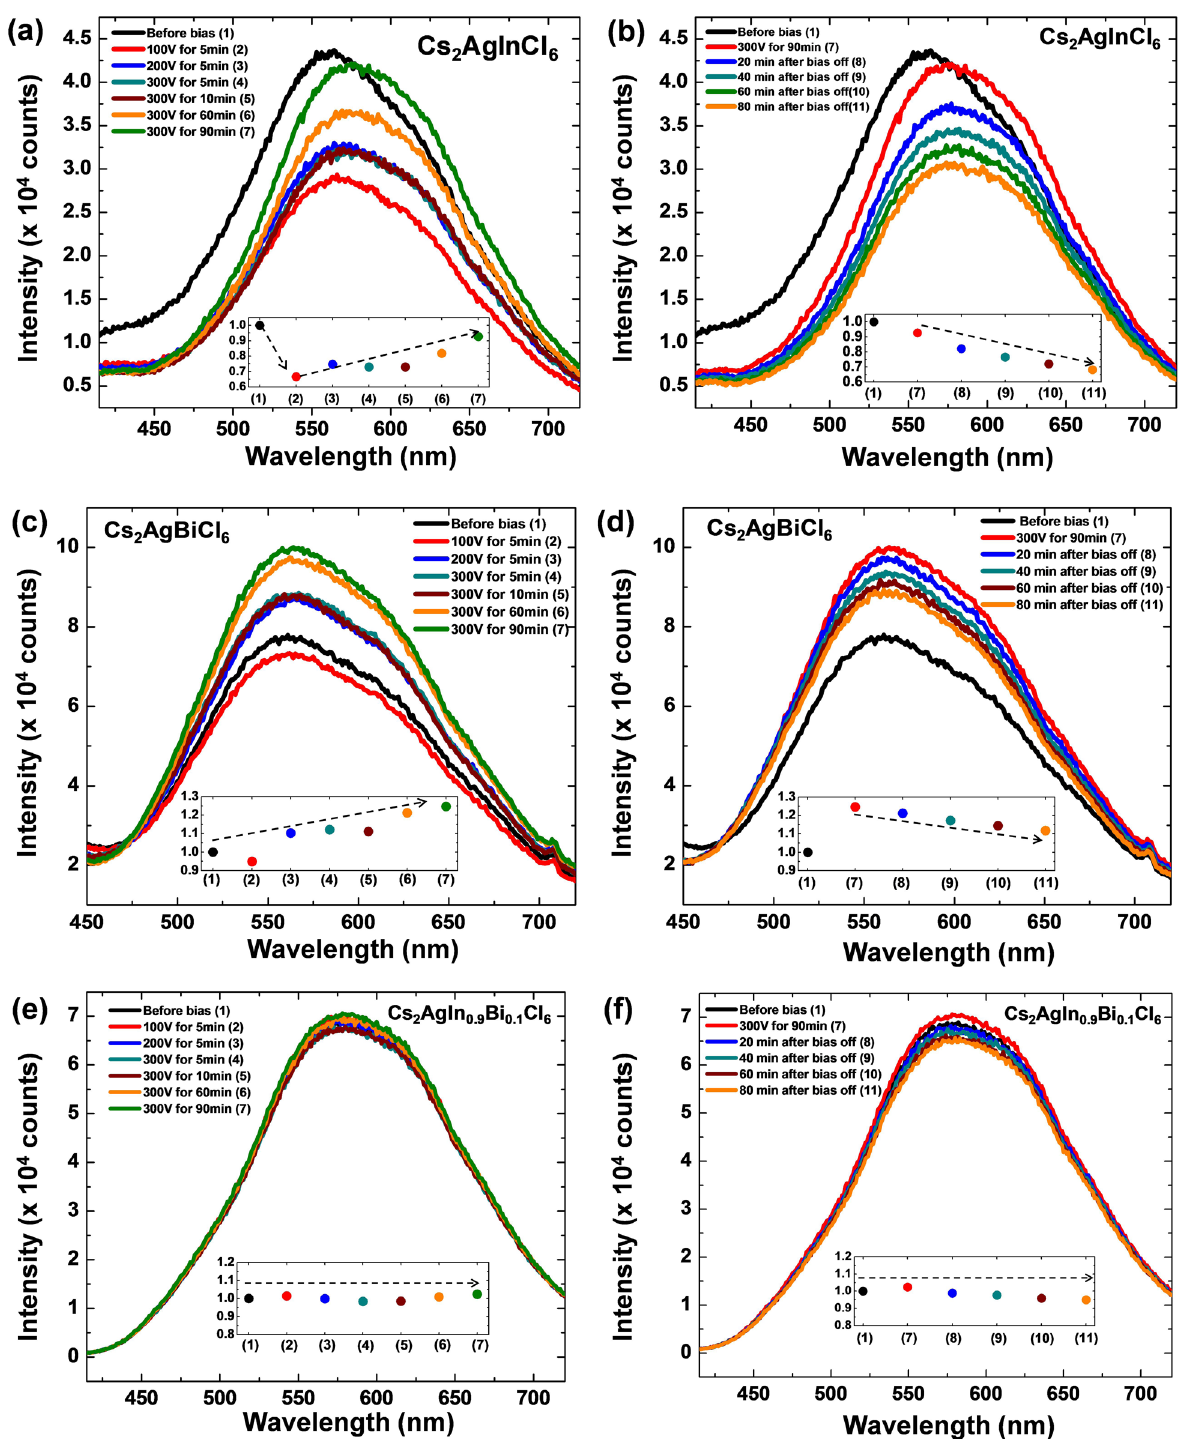
Fig. 7 Electric-bias-dependent photoluminescence properties. Photoluminescence spectra of ( a , b ) Cs 2 AgInCl 6 , ( c , d ) Cs 2 AgBiCl 6 , and ( e , f ) Cs 2 AgIn 0.9 Bi 0.1 Cl 6 . Plots ( a , c , and e ) show the spectra of compounds under various applied voltages at different times. The inset shows the integrated intensity of photoluminescence curves at various measurement conditions. Plots ( b , d , and f ) show the spectra at different intervals after switching off the voltage